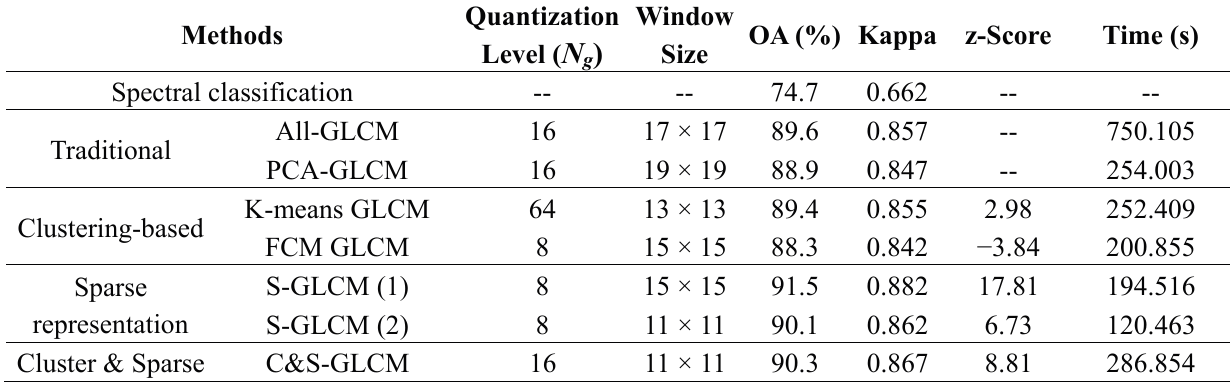
Table 3. The classification accuracies achieved by the different texture extraction algorithms with their optimal parameters. The z-scores between the proposed methods and PCA-GLCM are also reported (GeoEye-1 Wuhan image).